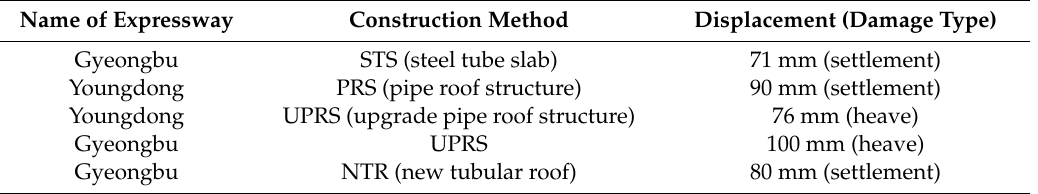
Table 2. Case of blocking o ff tra ffi c urgently during construction in the non-open-cut